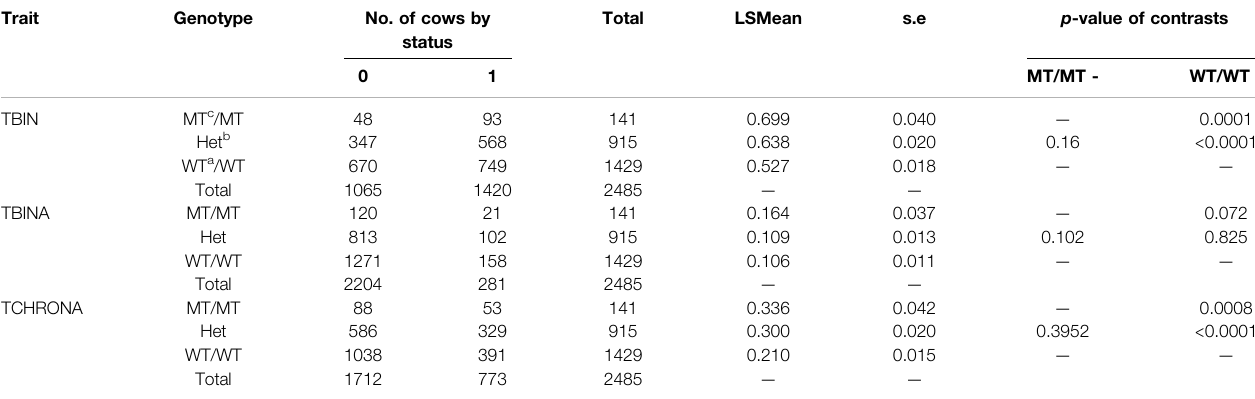
TABLE 2 | FRET analysis (Ensembl genome assembly ARS-UCD1.2) results of rs208894039 (BTA11). LSMEANs for the probability of being diseased according to trait de fi nitions TBIN, TBINA, and TCHRONA are given along with the number of animals in each sub-cell and the statistical contrasts between genotypes.